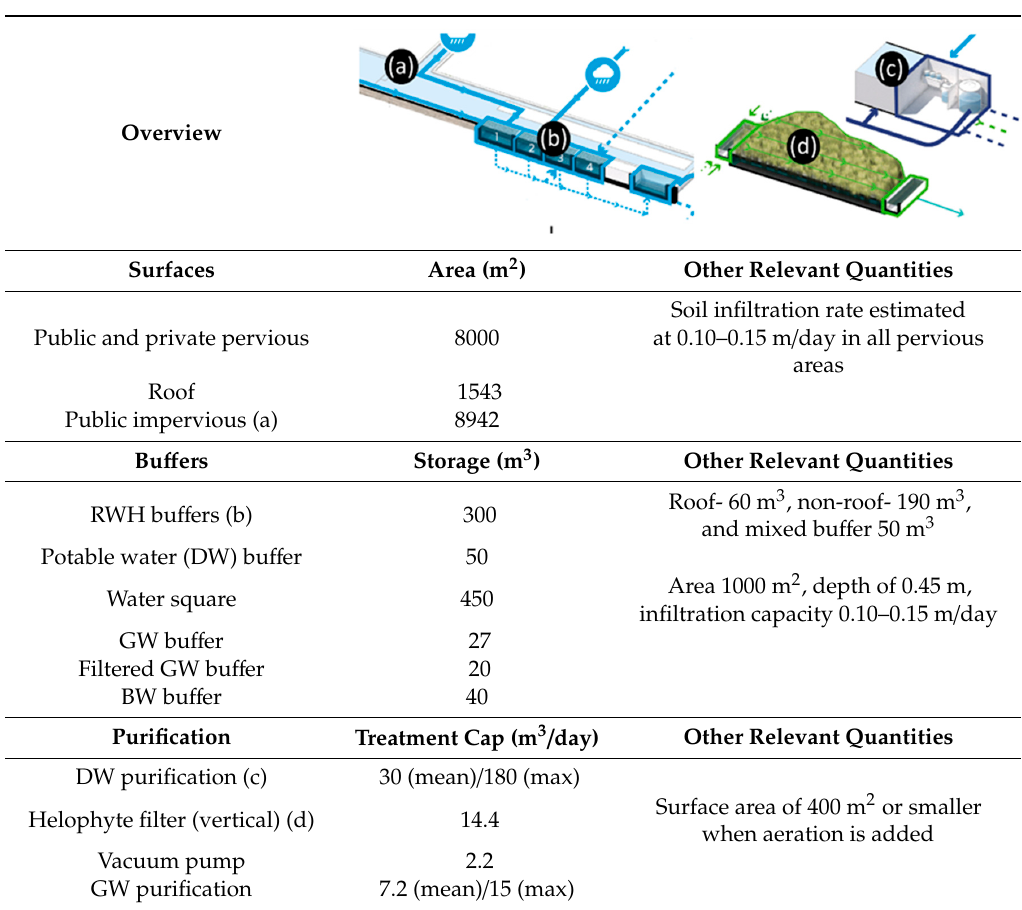
Table 4. Design attributes of SUPERLOCAL. Table 4 . Design attributes of